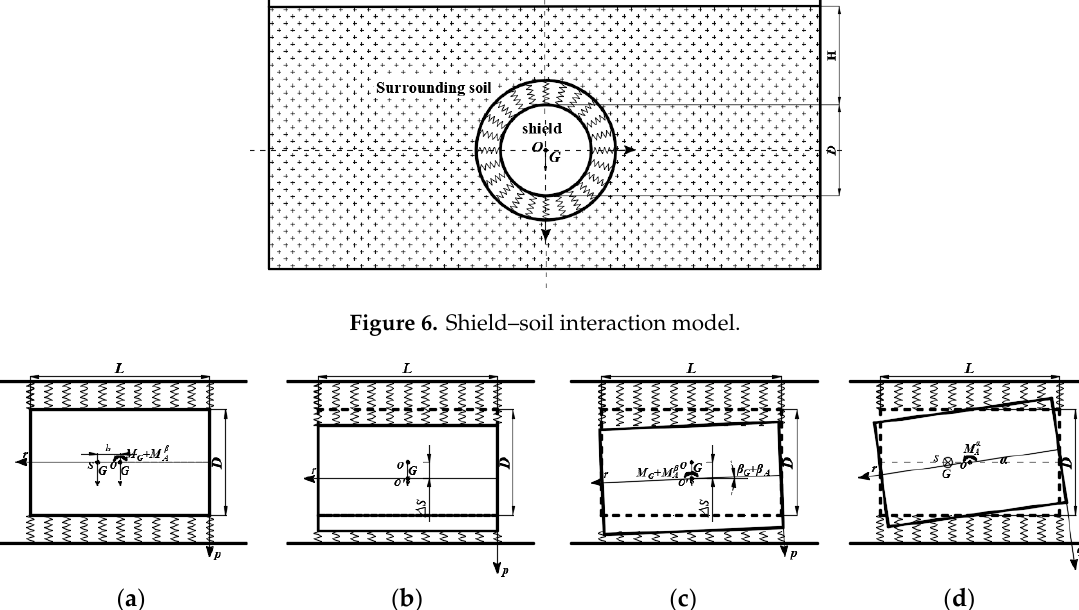
Figure 7. Shield attitude change process: ( a ) Stage1; ( b ) Stage2; ( c ) Stage3; and ( d ) Stage 4.